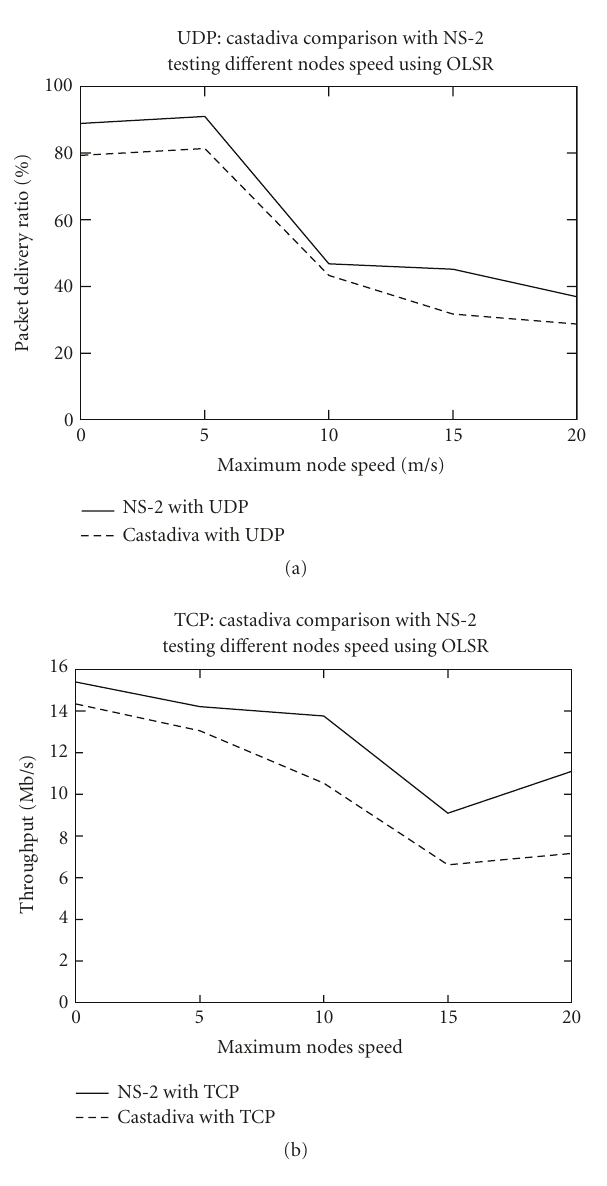
Figure 19: Comparison of Castadiva and ns-2 using OLSR at di ff erent node speeds with both UDP (a) and TCP (b) tra ffi c.